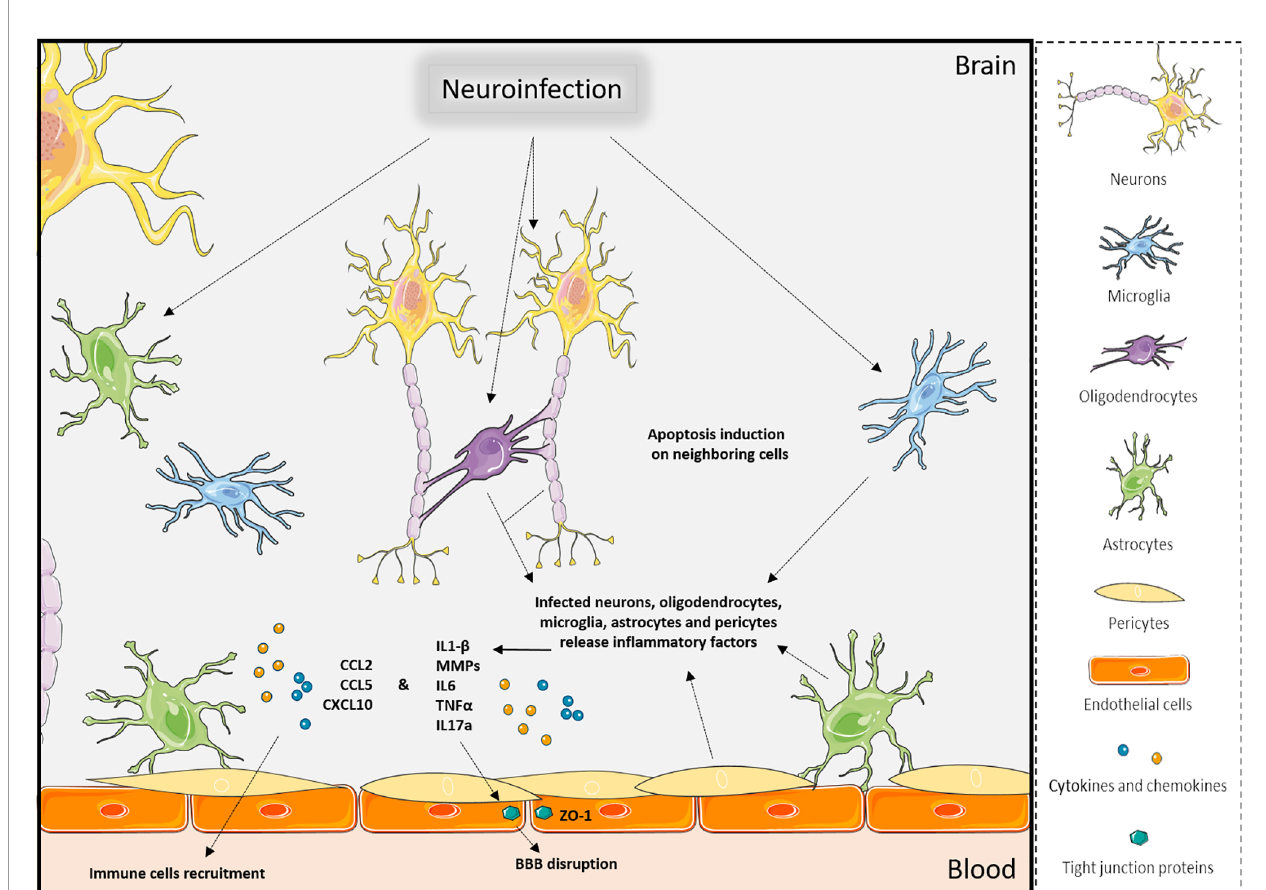
FIGURE 2 | Effects of neuroinfections in the CNS. Viral brain infections will trigger multiple molecular and cellular mechanisms in the various CNS cell types that can lead to apoptosis of neuronal cells, release of pro-in fl ammatory factors, disruption of brain barriers, and immune cell recruitment, which ultimately will exacerbate neuroin fl ammation. Created with SMART Servier Medical